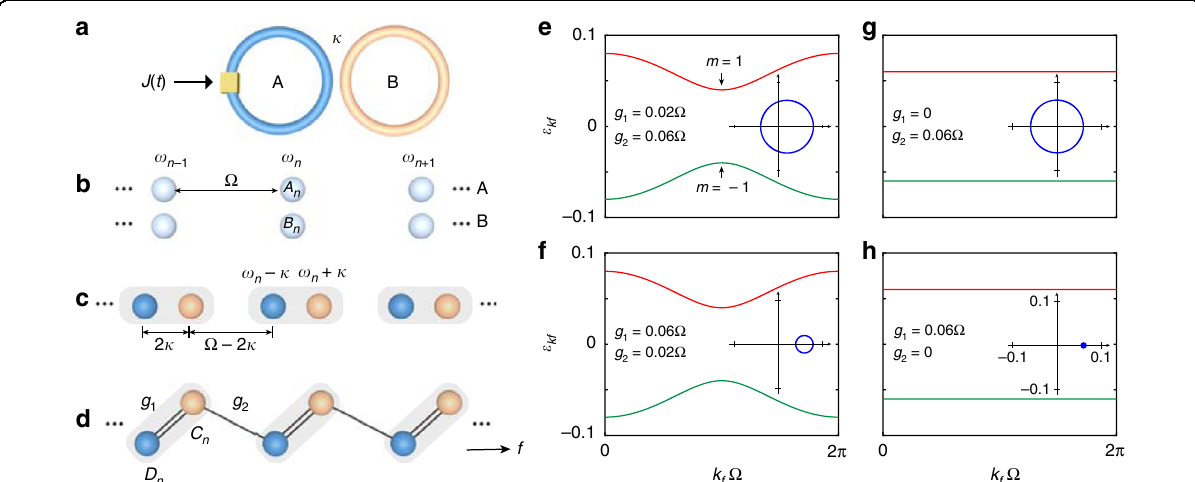
Fig. 1 Con fi guration of the 1D synthetic SSH model. a Illustration of two identical coupled ring resonators with coupling strength κ , while ring A undergoes dynamic modulation in the form of J ( t ) described by Eq. (1). b For an individual ring, ring A (B) supports equally-spaced resonant modes labeled as A n ( B n ) at frequency ω n . c After the effective coupling between two rings, the resonant modes in the system split into two symmetric and antisymmetric supermodes located at ω n ± κ . d The discrete supermodes in ring A are coupled by bichromatic modulation J ( t ), which can be mapped into a 1D photonic SSH model along the frequency dimension. The supermodes C n and D n act as synthetic lattice sites, with alternating hopping amplitudes g 1 and g 2 . e – h The analytical band structures of the synthetic SSH model in ( d ) under different hopping strengths g 1 and g 2 . Inserted: the corresponding traces of Re( G ) and Im( G ) as the wave vector evolving through the fi rst Brillouin